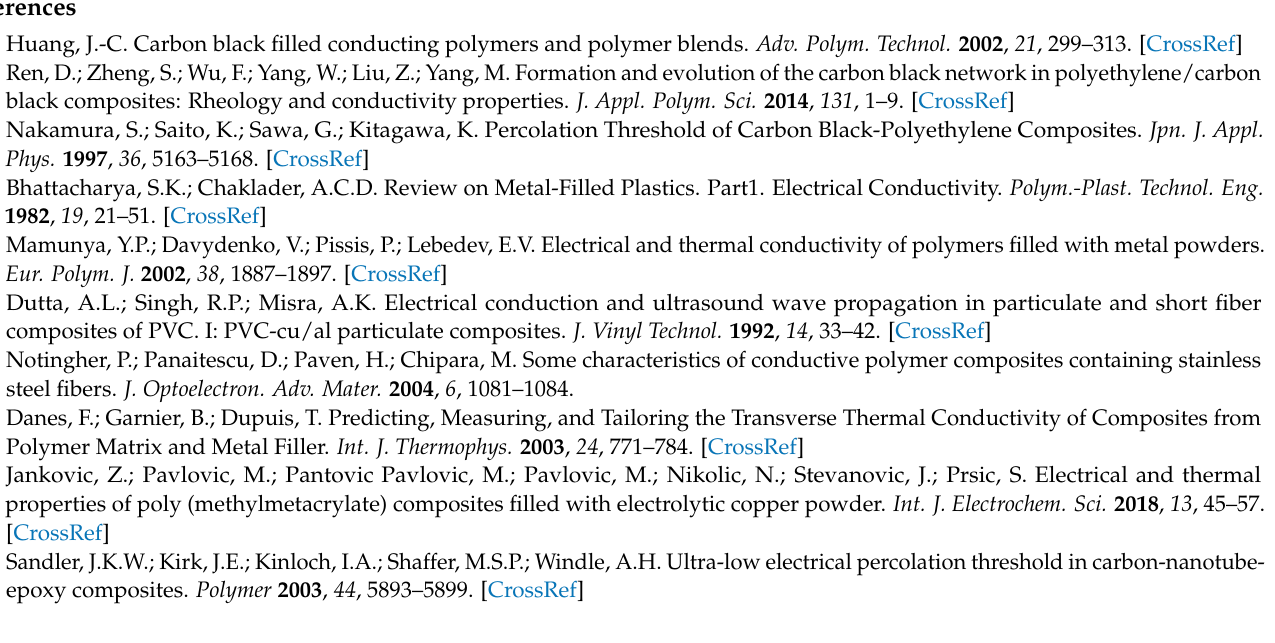
was semi-crystalline, Figure S2: DSC thermogram of the PET pellet. The melting curve is typical of semi-crystalline PET, Figure S3: Wide angle X-ray diffractogram of the nanoplatelet Aluminium powder used in the work. Figure S4: Stress – Strain curves for amorphous PET (9 samples). Amor- phous materials are prone to physical ageing, which causes a reduction in elongation-to-break with increasing storage time. Figure S5: Stress – Strain curves for 5 vol. % nanoplatelet Al-PET composite (5 samples). Figure S6: Stress – Strain curves for 10 vol. % nanoplatelet Al-PET composite (6 samples). Figure S7: Stress – Strain Curve for 15 vol. % nanoplatelet Al-PET composite (8 samples). Figure S8: Stress – Strain Curve for 20 vol. % nanoplatelet Al-PET composite (7 samples). Figure S9: Stress – Strain Curve for 25 vol. % nanoplatelet Al-PET composite (8